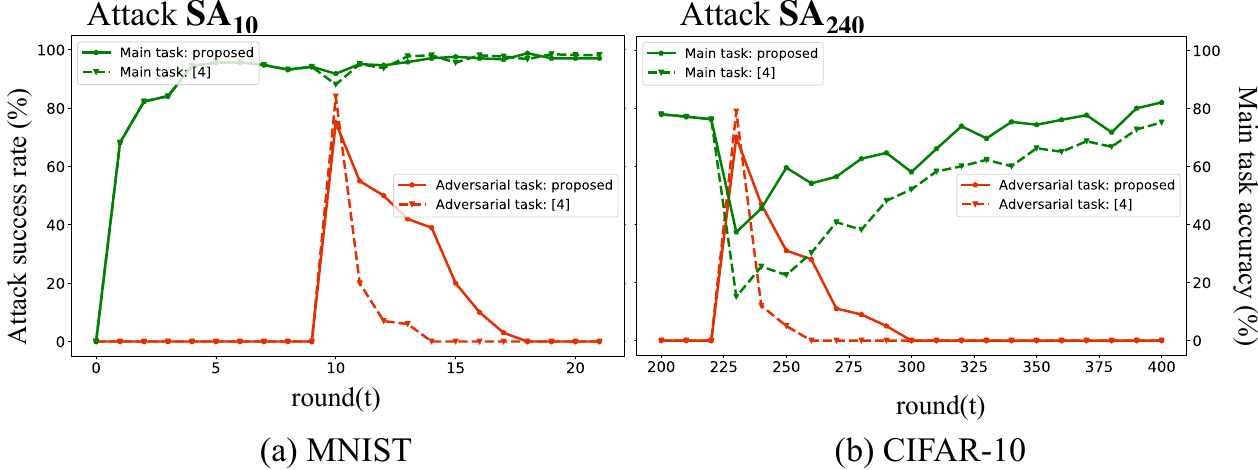
Figure 5. A comparison of the accuracy (green) and attack success rate (red) for shared global model between proposed deep model poisoning and backdoor attack in [4] under single-shot attack scenario. Different from MNIST dataset, we use 2 × η to scale up malicious client’s model update in the CIFAR-10 n